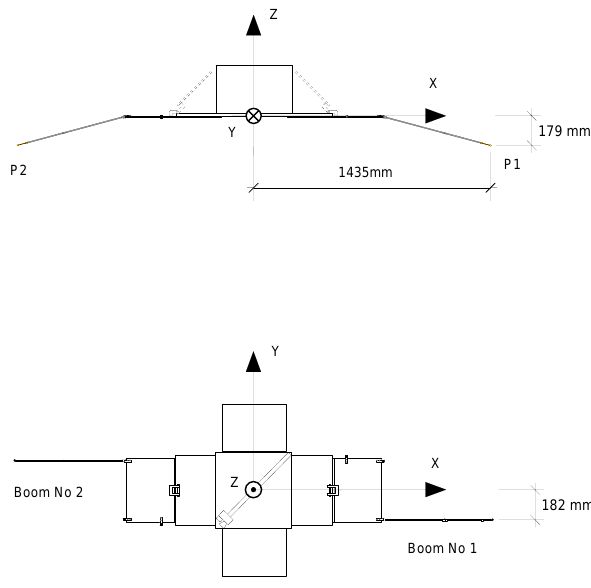
Fig. 6. The Astrid-2 co-ordinate system and LINDA boom geome-